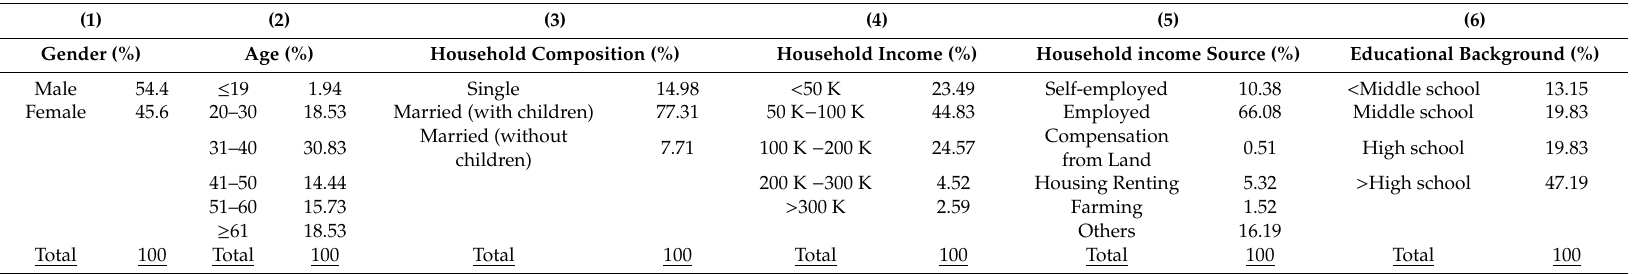
Table 2. Distribution of Demographic Information of the Surveyed Household